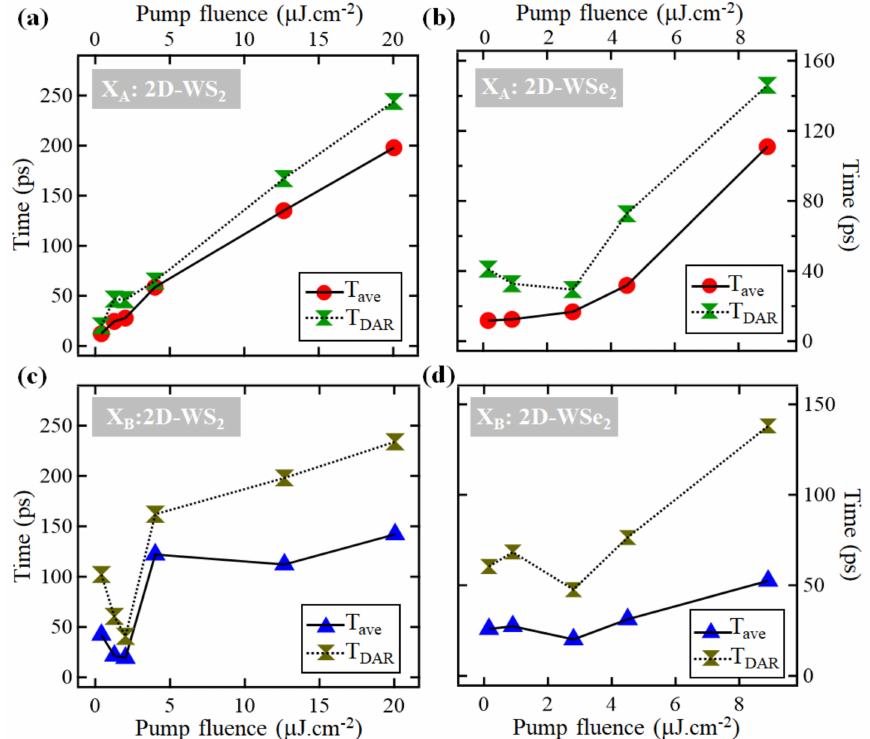
Figure 5. Dependence of T ave and T DAR of the depletion recovery dynamics of excitons on the pump fluence: ( a ) For exciton X A in 2D-WS 2 ; ( b ) For exciton X A in 2D-WSe 2 ; ( c ) For exciton X B in 2D-WS 2 ; ( d ) For exciton X B in 2D-WSe 2